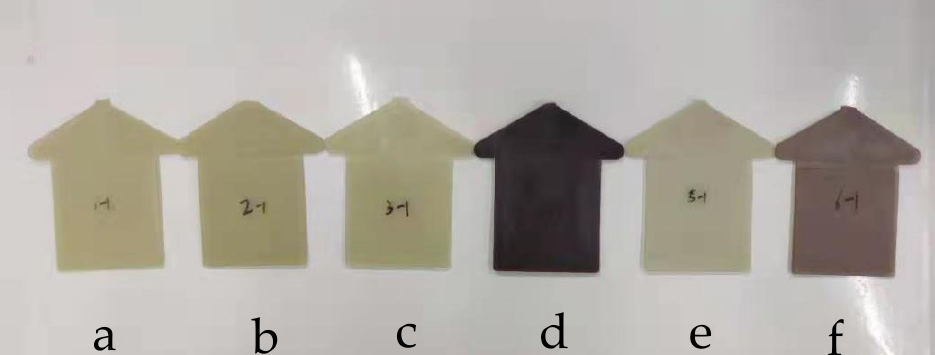
Figure 6. Comparison of the color of plate specimens at the beginning of aging ( a ) 1, ( b ) 2, ( c ) 3, ( d ) 4, ( e ) 5, ( f ) 6.